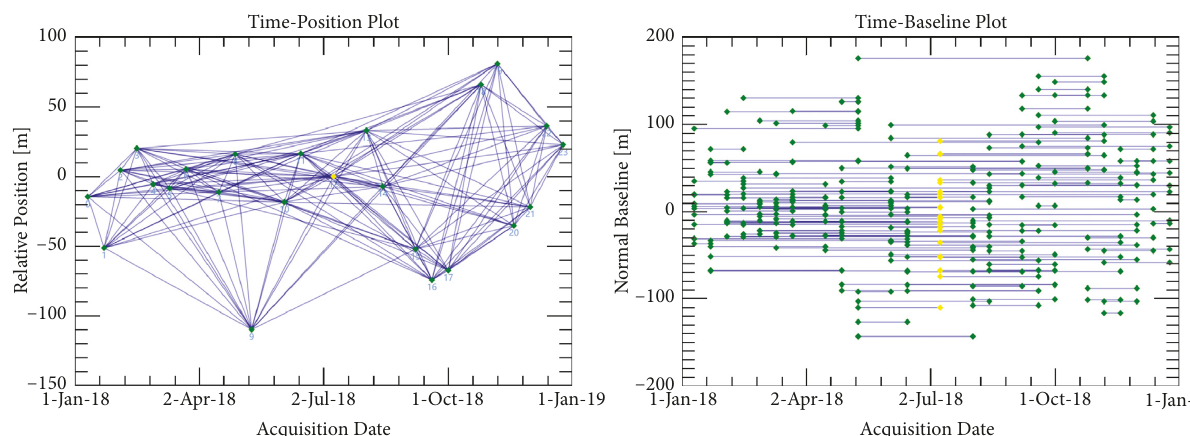
Figure 7: Spatial and temporal baselines in this study. The yellow diamond denotes the super master image, the green diamonds denote the slave image, and each blue line denotes a connection from the master image to the slave image.